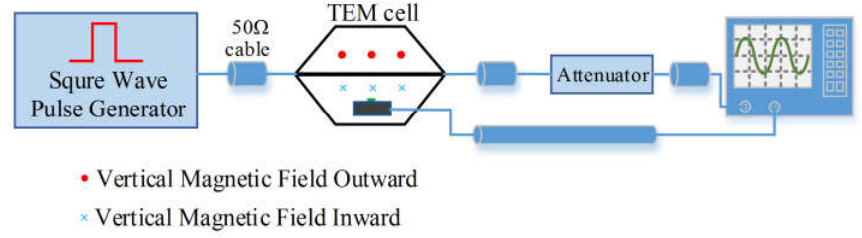
Figure 7. Schematic diagram of detector calibration.